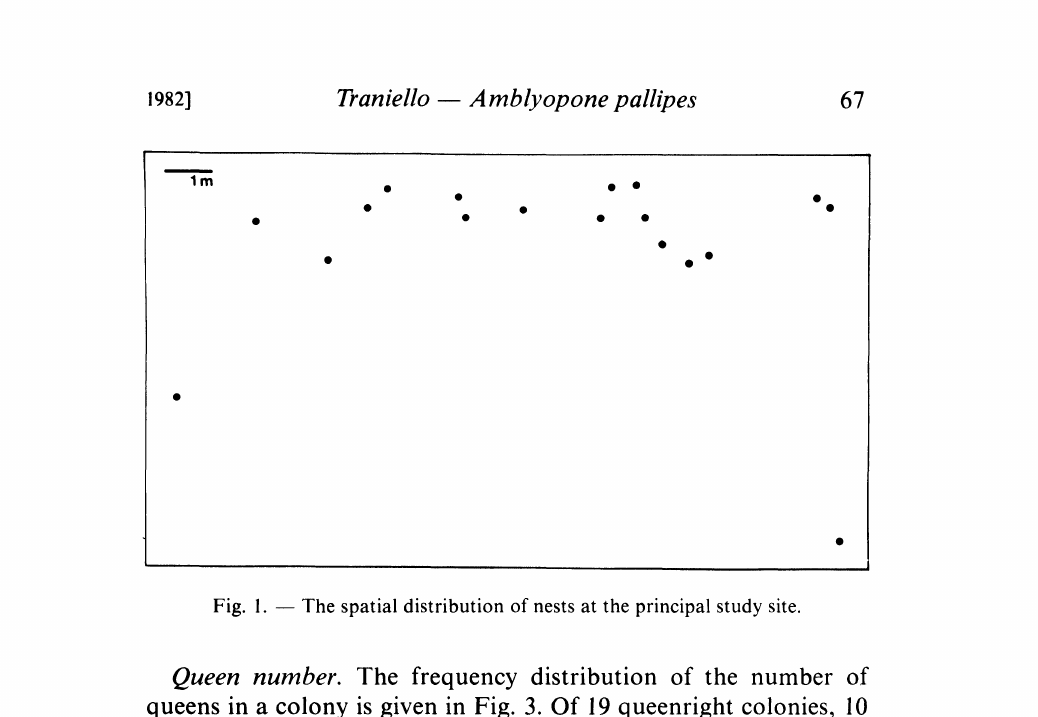
Fig. 1. The spatial distribution of nests at the principal study